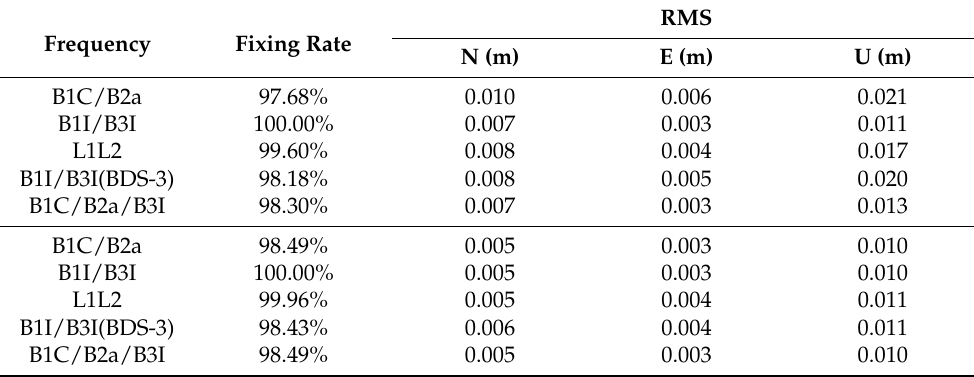
Table 5. METG–MET3 (3 km) average of instantaneous short baseline RTK RMS and ambiguity fixing rate. The upper part of the table is the instantaneous ambiguity fixing strategy, and the bottom part of the table is the continuous ambiguity fixing strategy.